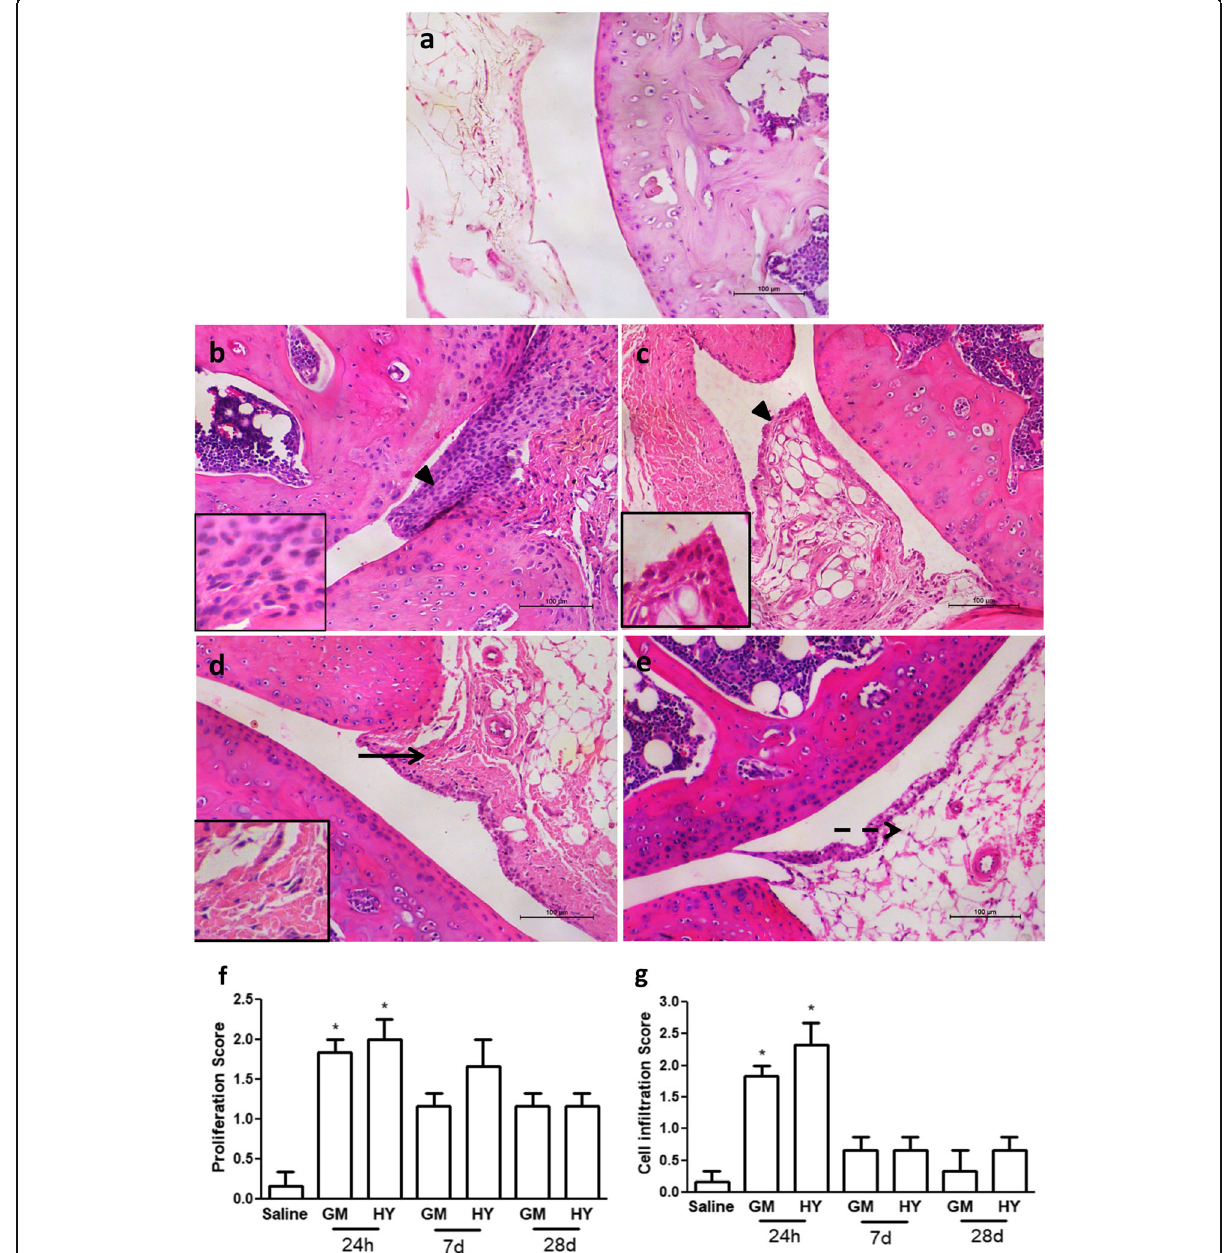
Fig. 2 Representative illustration of the histopathology of mice knees after injection of guar gum (GM) or Hylan G-F20 (HY) (100 μ g/25 μ L) or saline into naïve joints and analysis of histopathology scores. Knee joints were excised after 7 or 28days and processed for hematoxylin – eosin staining. Saline-injected joints appear normal ( a ); there is mild synovial hyperplasia (arrow-heads) in GM and HY-injected joints at 7days ( b and c , respectively; insets); at 28days, there is no long synovial hyperplasia with mild fibrosis in HY ( d , arrow; inset) with apparently normal fat subsynovial tissue in a GM- injected joint ( e , dashed arrow) (Original magnification ×200). Proliferation of synovial cells ( f ) and cell influx ( g ) into the synovia were evaluated under optical microscopy using HE and Safranin-O staining. Data are medians (IQR) of n =6/group; * p <0.05 using Kruskal-Wallys